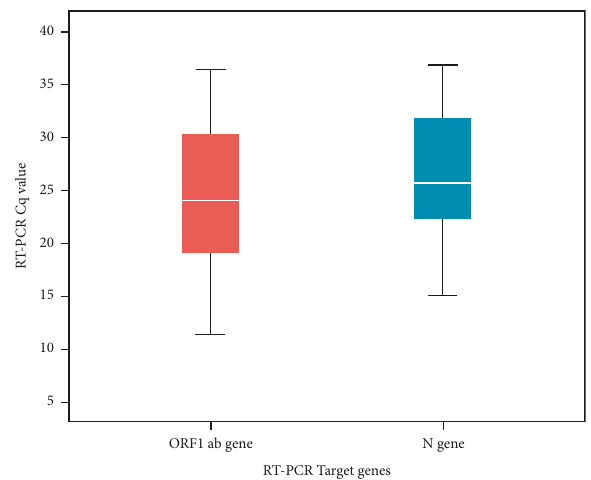
Figure 2: Cq value distribution of RT-PCR target genes. Middle horizontal line inside the box denotes the median. The boxes represent interquartile range (lower, 1st quartile and upper, 3rd quartile). The lower and upper whiskers represent minimum and maximum C q values, respectively.